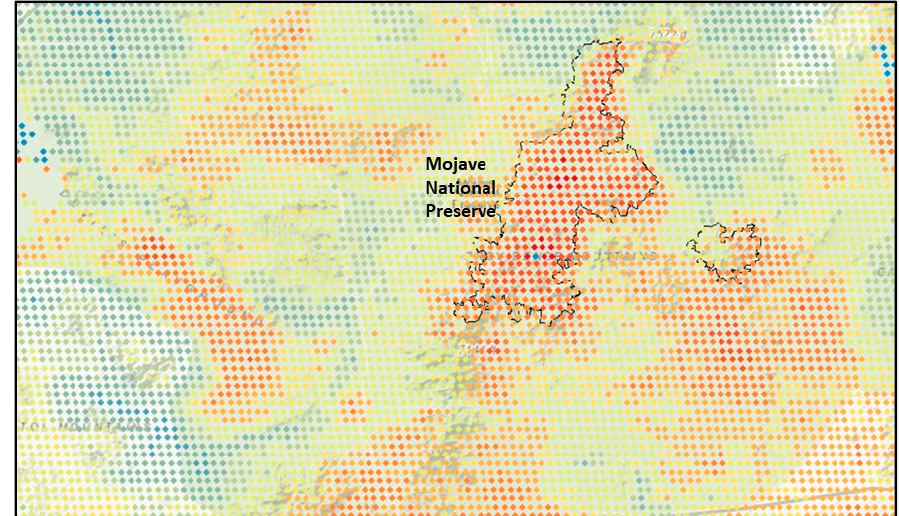
Figure 14. LST slope results around an area burned by the Hackberry Complex Fire of 2005 (centered at 35.14° N, 115.41° W) within the Providence Mountains of the Mojave National Preserve with positive (warming) BFAST LST slope values in orange-red shades and negative (cooling) LST slope values in blue shades; areas of change in LST are shaded in yellow. The map is upward in the northern direction.